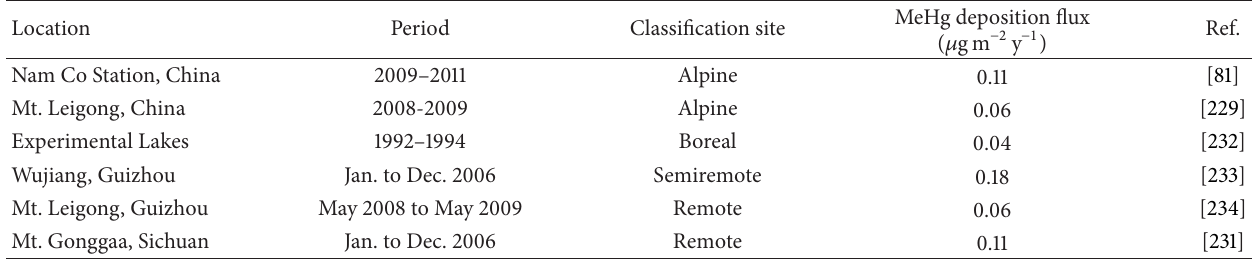
Table 12: Collection of some data of MeHg deposition fluxes.